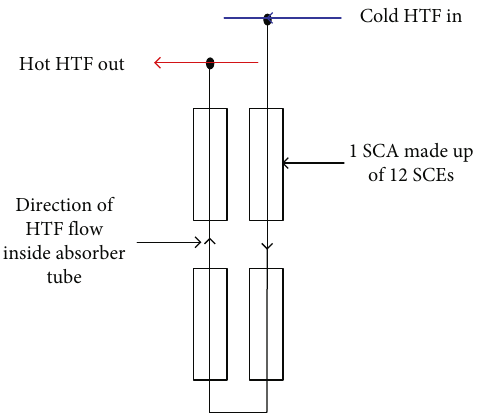
Figure 2: A single loop in the PTC solar fi eld [34].